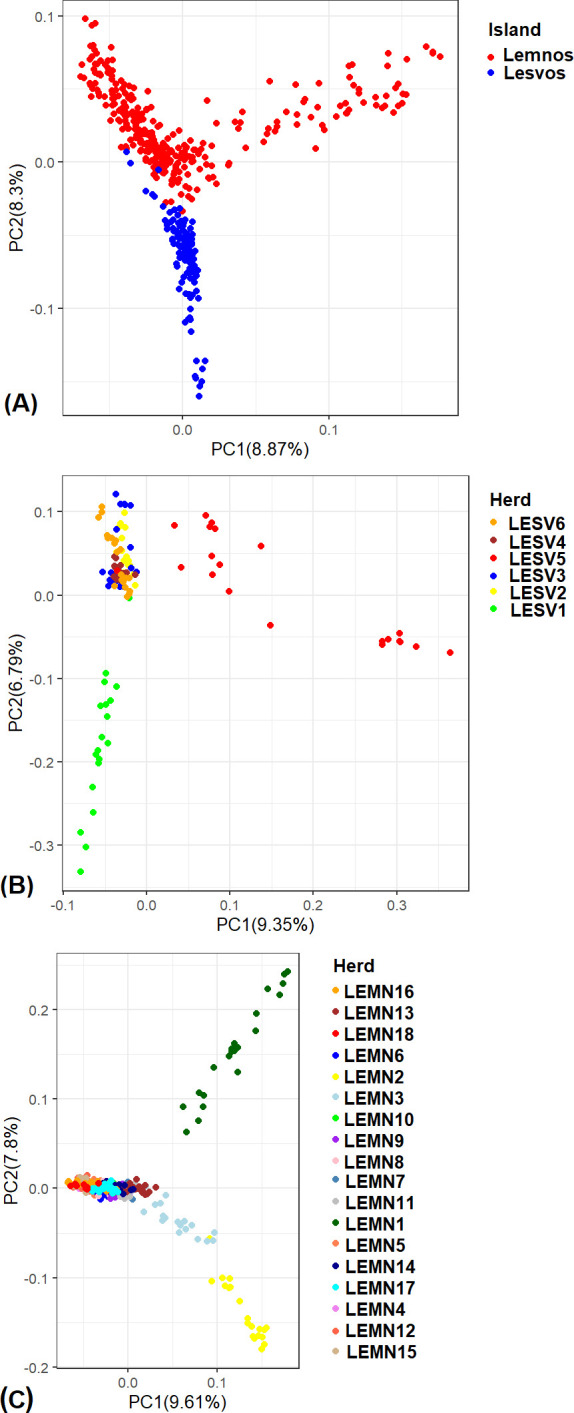
Two-dimensional plots of the first two principal component (PC) axes of genetic variation (labeled PC1 and PC2) of sheep genotypes per island (A), for Lesvos (B) and Lemnos (C). The percentage of variance each PC axis explained is also provided. Each point represents an individual genotype and points are colored by island (top) and herds within islands (middle and bottom). Plots were constructed using the ggplot2 R package [15].